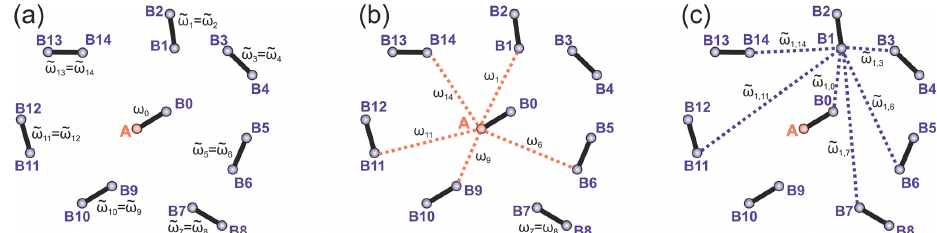
Figure 2. Intra- and intermolecular electron–electron coupling frequencies for the case of a frozen solution of biradicals. (a) Intramolecular dipolar frequency for the target biradical, containing the A spin ( ω 0 ) and the intramolecular dipolar frequencies in other biradicals ( ˜ ω i ), both spins in these biradicals are B spins. (b) Intermolecular dipolar frequencies ω i describe couplings of A spin to remote B spins. (c) The dipolar frequencies ˜ ω i,j describe intermolecular dipolar couplings between B spins. The case of a frozen solution of monoradicals is obtained by keeping only the intermolecular dipolar frequencies and dropping the intramolecular ones. Only a selection of intermolecular couplings is shown in the figures to reduce visual crowding. Table 1. Most important terms describing the spin density matrix and the detected signal contributions. Term Equations